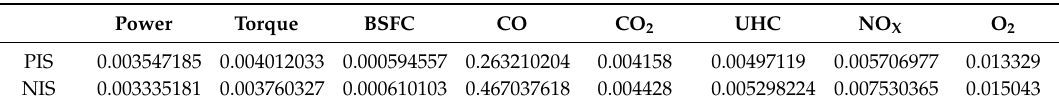
Table 8. Positive ideal solution (PIS) and negative ideal solution (NIS) values for each dependent variable of engine test.